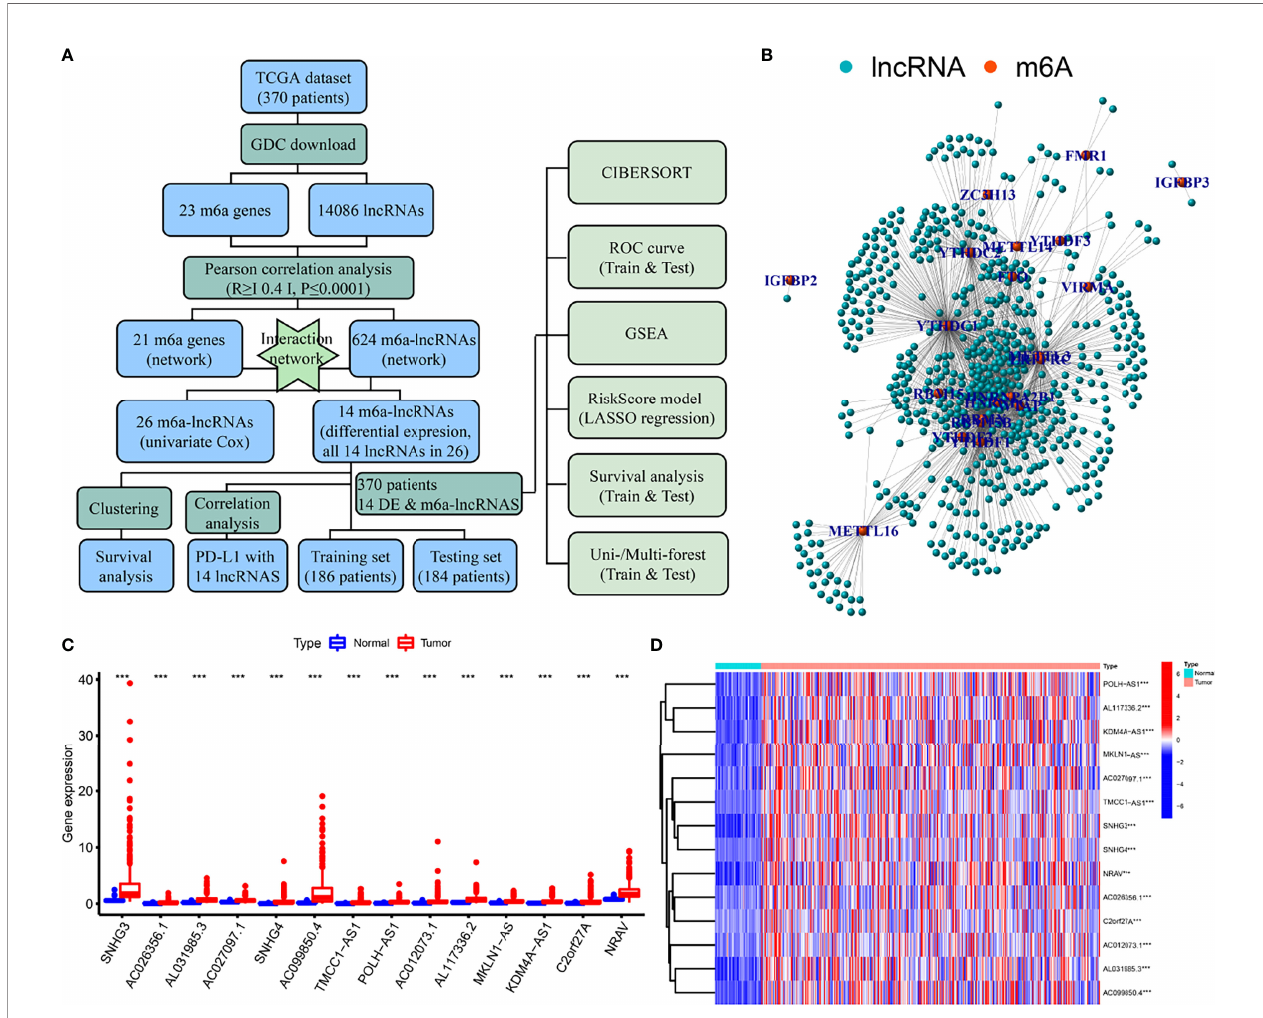
FIGURE 1 | Flow diagram, interaction network, and differential analysis. (A) Flow diagram of the present study, (B) Interaction network of m6a-related mRNA and lncRNAs, (C, D) Box plots and heatmap of differential lncRNAs. *** means